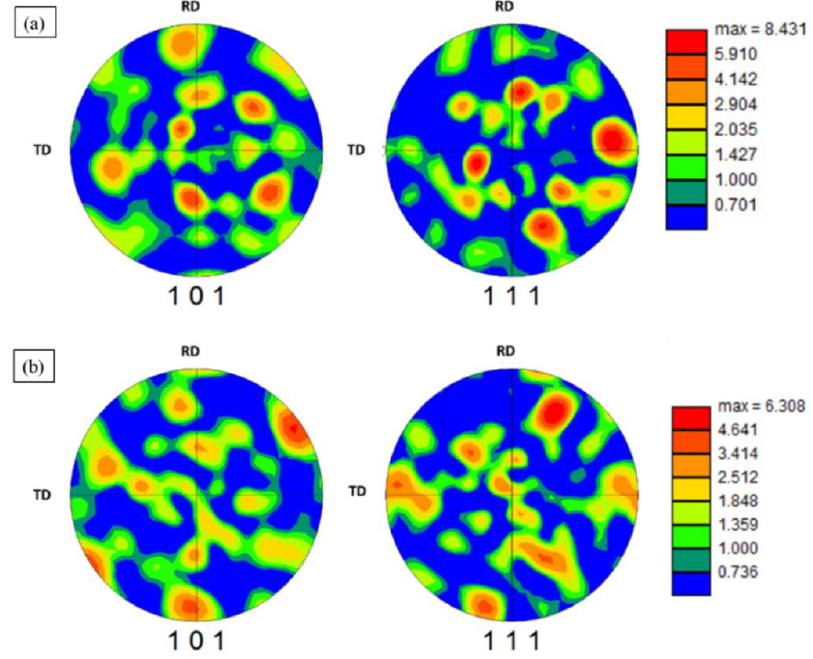
Figure 12. 101 and 111 pole figures (PFs) of BMs, where ( a ) AA2024-T4 and ( b ) AA7075-T6.